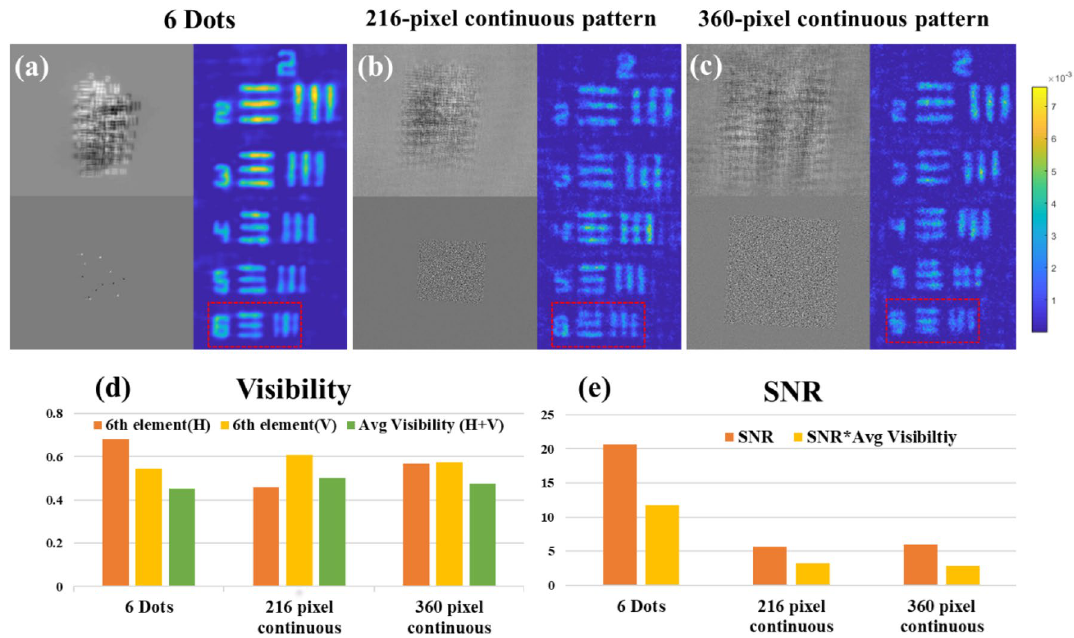
Figure 1. Reconstruction results of ( a ) dot pattern I-COACH system with bipolar OH and PSH, ( b , c ) continuous chaotic I-COACH system with constraints window of size 216 × 216 and 360 × 360 pixel along with bipolar OH and PSH, ( d ) visibility chart of 6th element, ( e ) SNR and SNR x Visibility